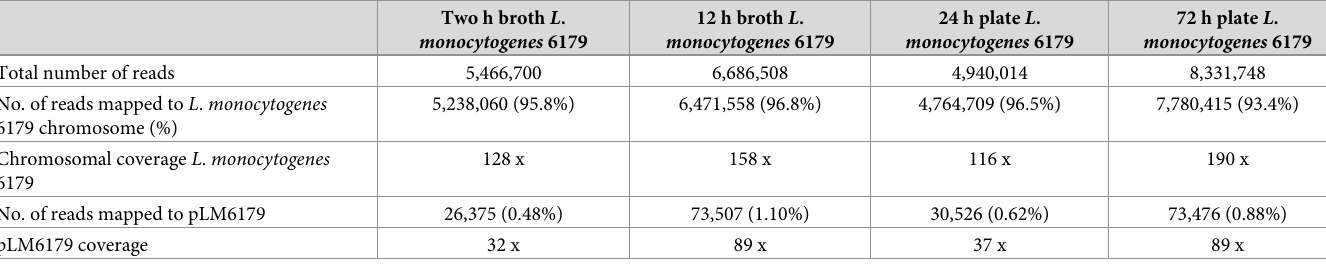
Values are reported as averages of each condition